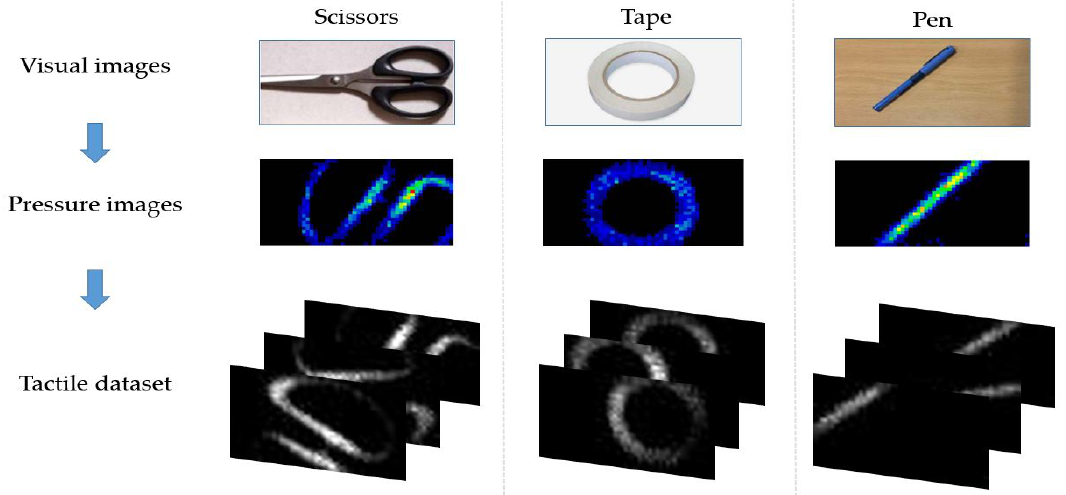
Figure 2. Examples of visual ( top ) vs. pressure ( middle ) vs. tactile images ( bottom ) of common